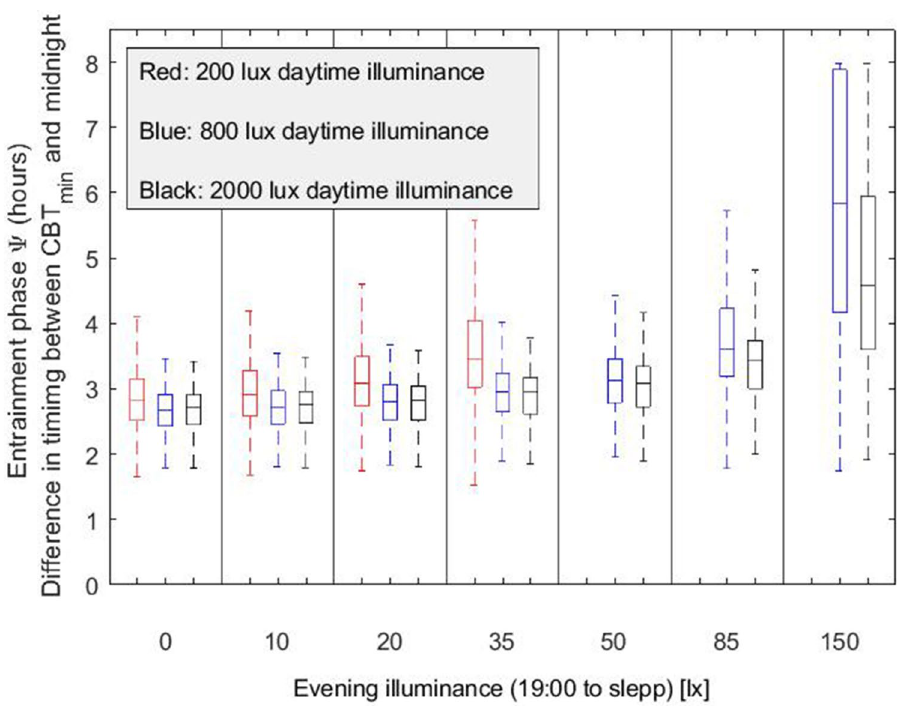
Figure 4. Entrainment phase angle distribution for a population of 200 simulated individuals with a normally distributed intrinsic circadian period with means (± SD) of 24.15 (± 0.2) h 33 . Illuminances represent the corneal light exposure (i.e., at the eye position). Results are presented for two different evening (19:00-sleep) illuminances of 10 and 35 lx, respectively, all with 200 lx daytime (wake-19:00)